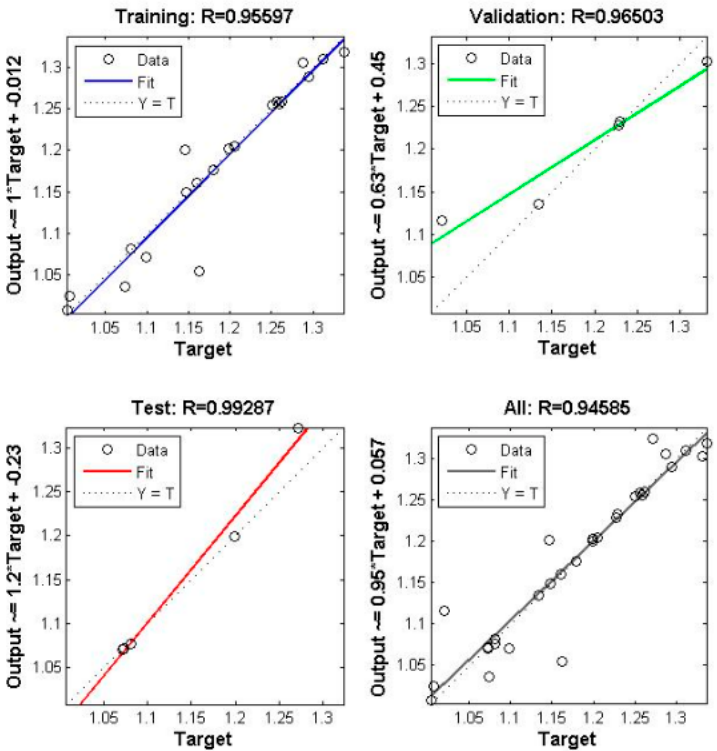
Figure 10. The regression plots of the model outputs.